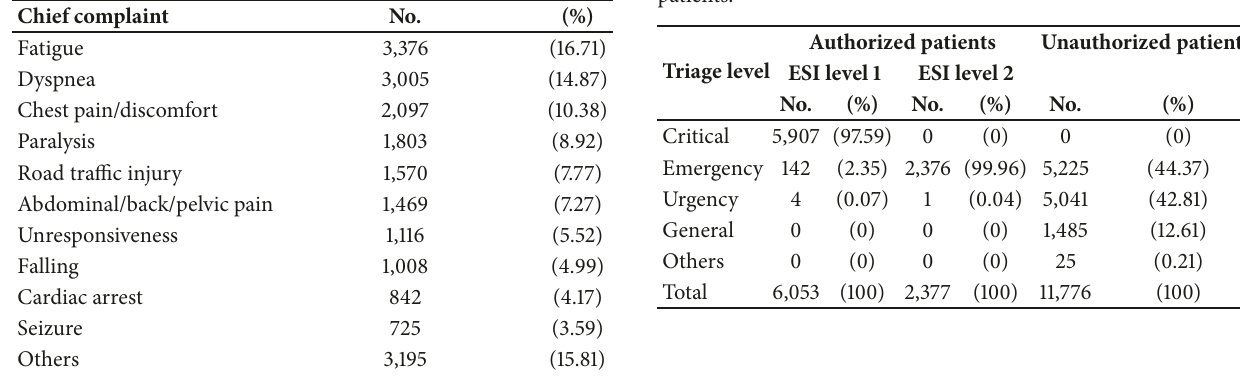
Table 4: Top ten ED chief complaints. Table 5: Level of urgency in the authorized and unauthorized